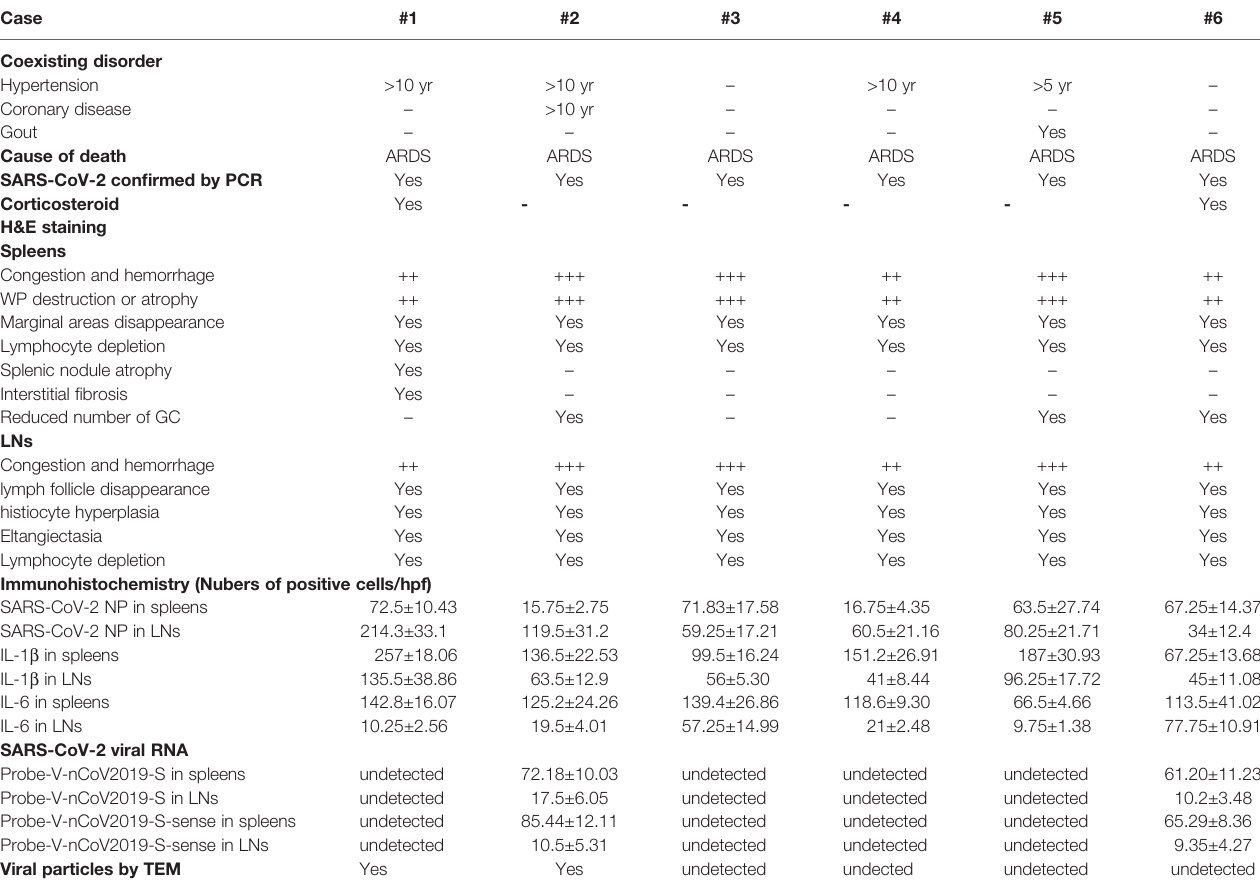
TABLE 2 | The pathologic fi ndings from COVID-19 patients undergoing postmortem